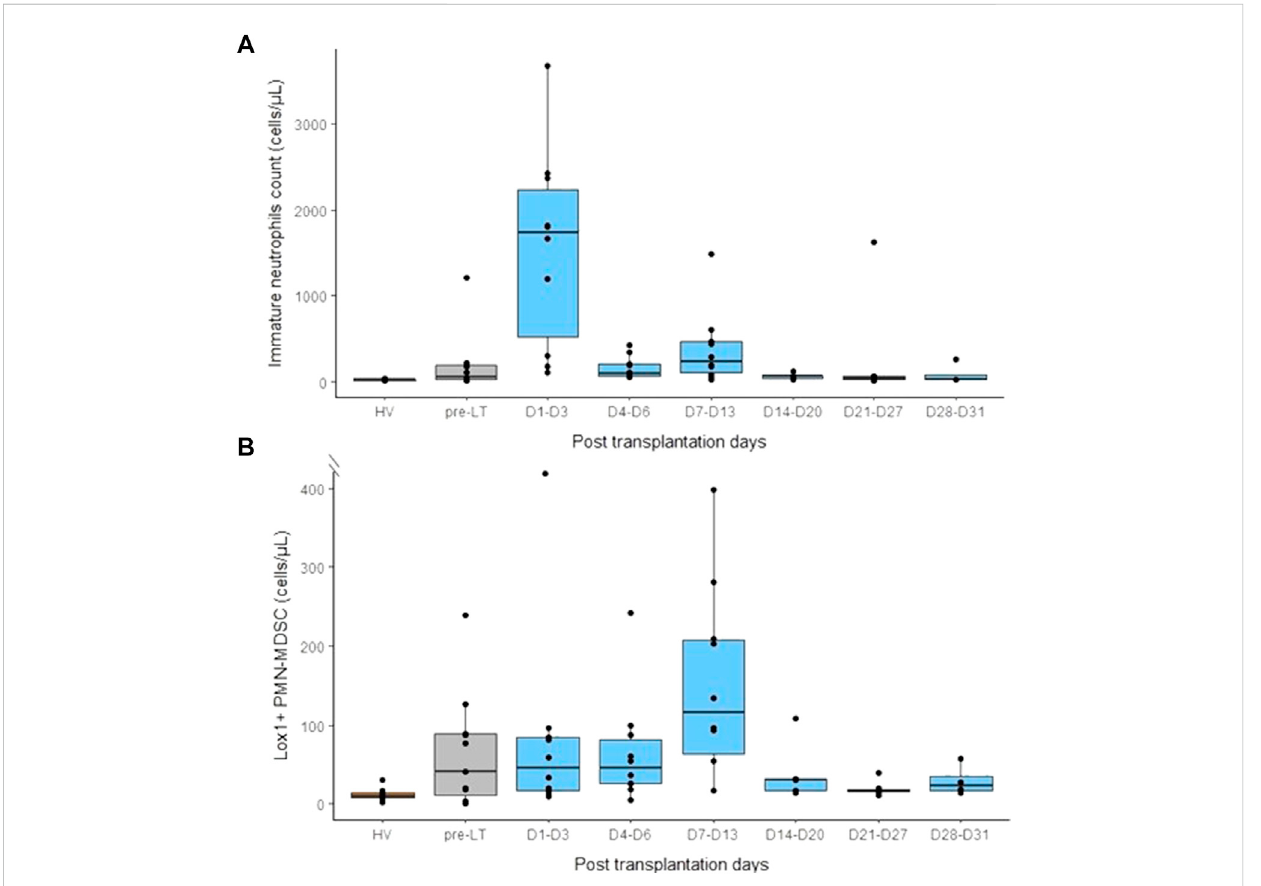
FIGURE 7 Monitoring of immature neutrophils (CD16low) and lectine-type oxidized LDL receptor 1 polymorphonuclear myeloid-derived suppressor cells (LOX1+ PMN-MDSC) in peripheral blood before and after liver transplantation. (A) Immature neutrophils count in healthy volunteers (HV, n = 15), pre- transplant patients (pre-LT, n = 11) and after liver transplantation at different time points (day 1 to day 3, n = 10; day 4 to day 6, n = 10; day 7 to day 13, n = 10; day 14 to day 20, n = 5; day 21 to day 27, n = 6; day 28 to day 31, n = 4). (B) Number of Lox1+ PMN-MDSC in healthy volunteers (HV), pre- transplant patients (pre-LT) and following transplantation at different time points. Pre-transplant data only concern patients that bene fi ted from